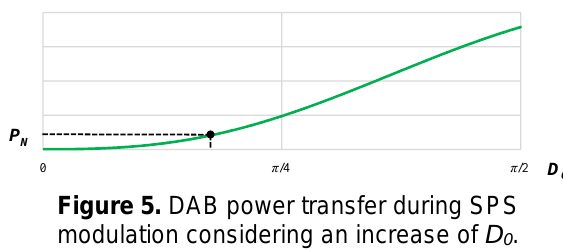
Figure 5. DAB power transfer during SPS modulation considering an increase of D 0 .